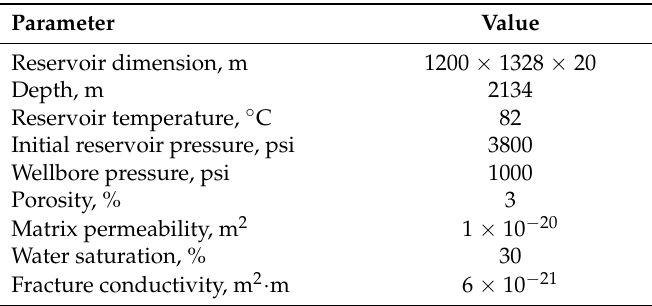
Table 1. Reservoir parameters.